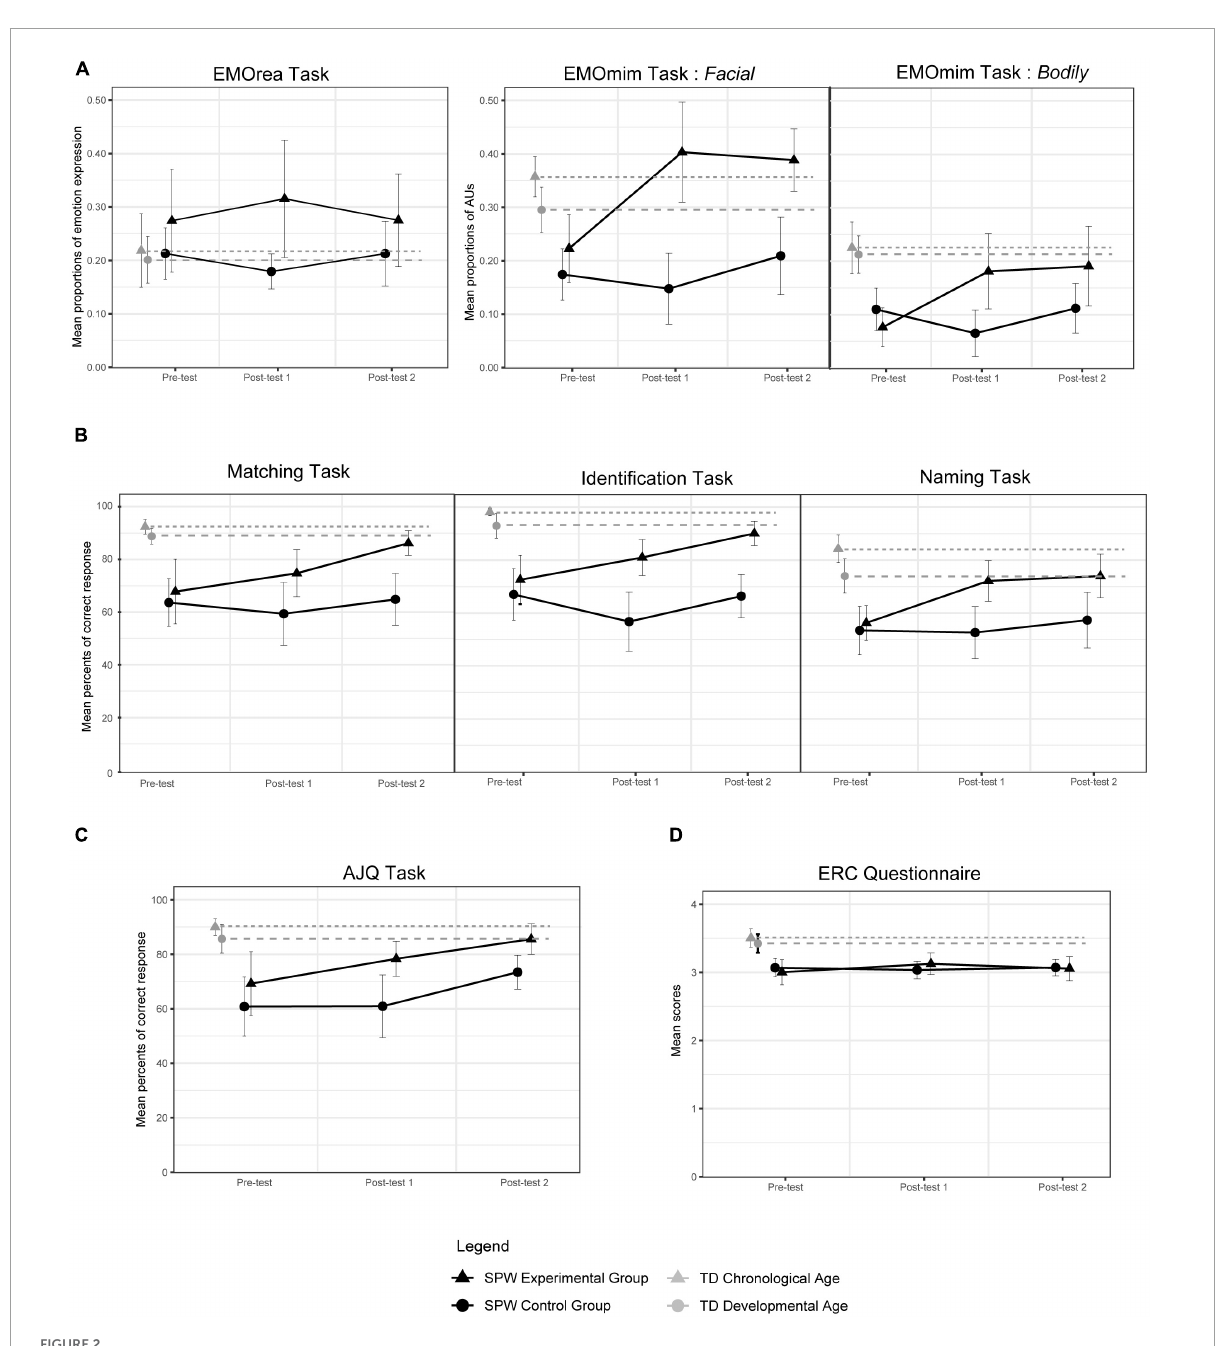
FIGURE2 Graphical results of the three test sessions for each task. (A) Expression. (B) Recognition. (C) Comprehension. (D)